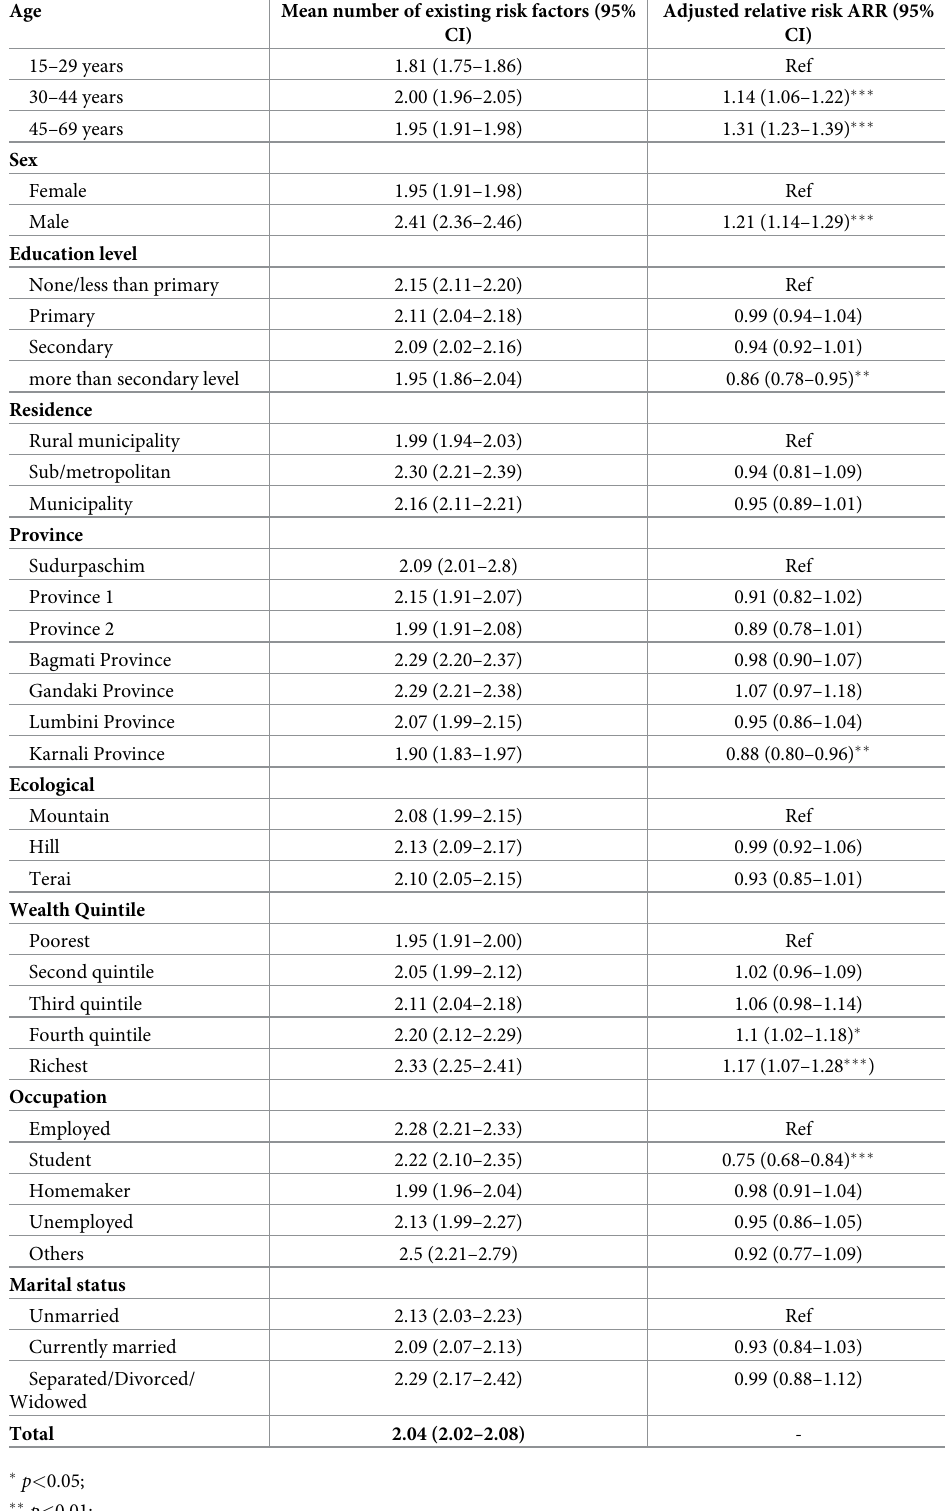
Table 4. Clustering of NCD risk factors and its multivariable